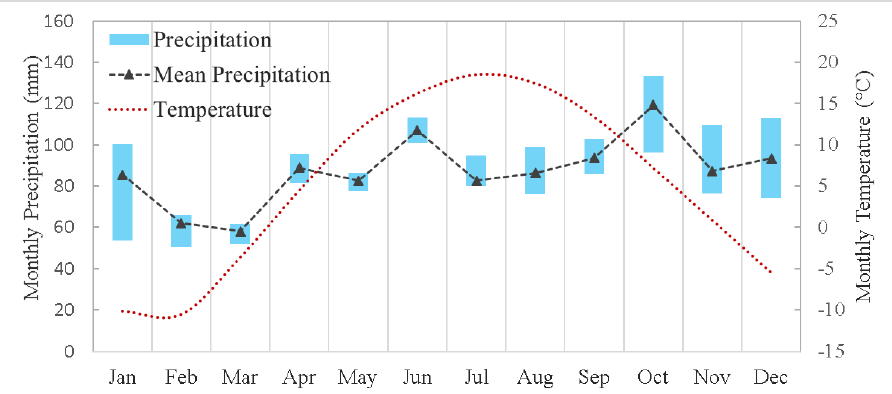
Figure 2. The box-plot and average of monthly precipitation and the mean monthly temperature for the observation period (2006–2015) based on data from six available meteorological stations.